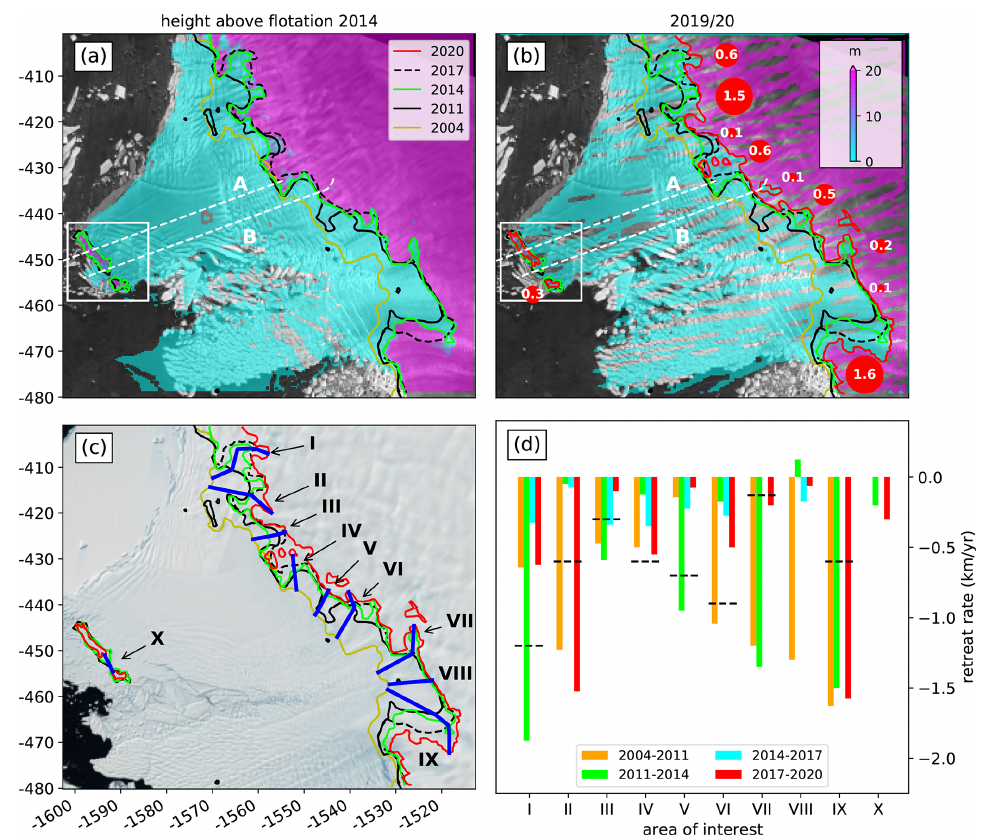
Figure 3. Regional changes: height above flotation from (a) REMA data in 2014 and (b) ICESat-2 surface altimetry data in 2019/20 overlain on a Sentinel 1 SAR image from October 2019. Airborne surveys from 2009 and 2019 (a, b) are shown as dashed white lines. Red circles in panel (b) show rates of grounding-line retreat since the last assessment in 2017 (Milillo et al., 2019). Roman numerals in panel (c) refer to areas of interest discussed in the text and are overlain on the Landsat Image Mosaic of Antarctica (Bindschadler et al., 2008). Panel (d) shows histograms of grounding-line retreat rates along the (blue) profiles in panel (c) in comparison to (dashed black) the InSAR-derived retreat rates between 2011 to 2017 from Milillo et al. (2019). The white rectangle (a, b) shows the spatial extent of Fig. 5.